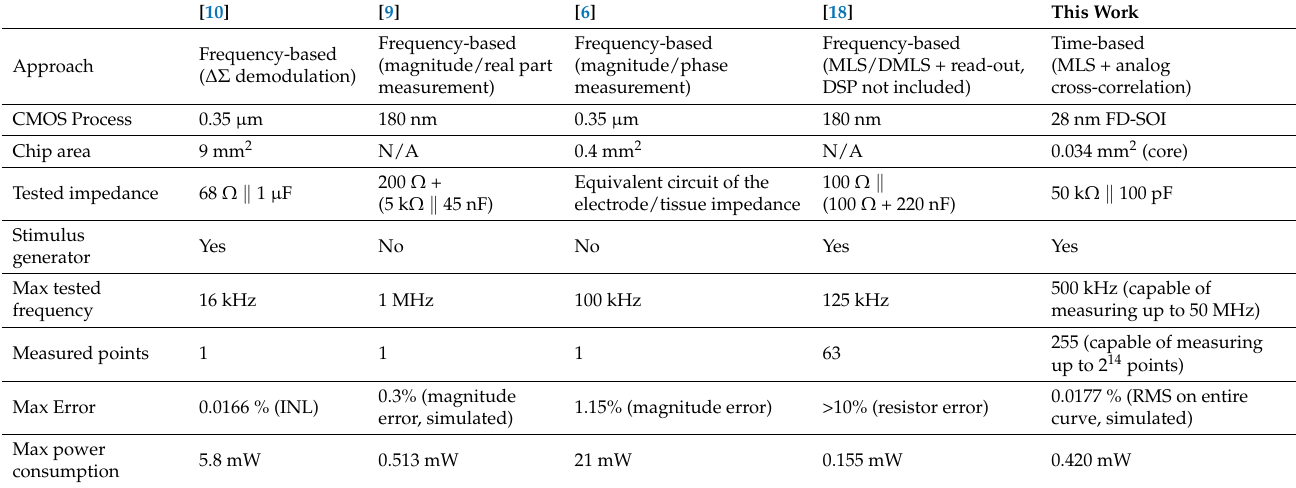
Table 2. Comparison with state-of-the-art